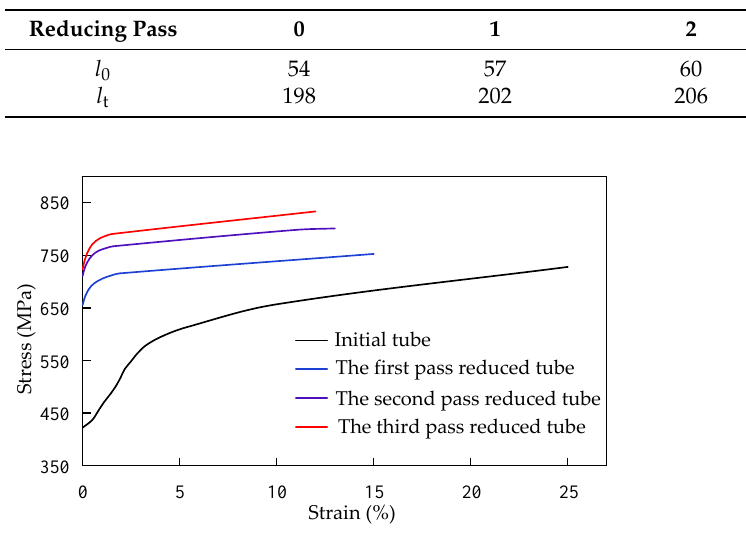
Figure 14. Stress-strain curve.